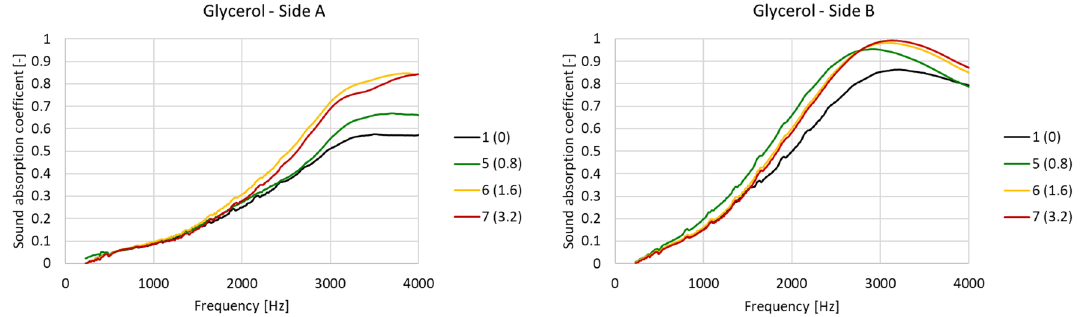
Figure 9. Variation in the sound absorption frequency coefficient at increasing glycerol concentrations.